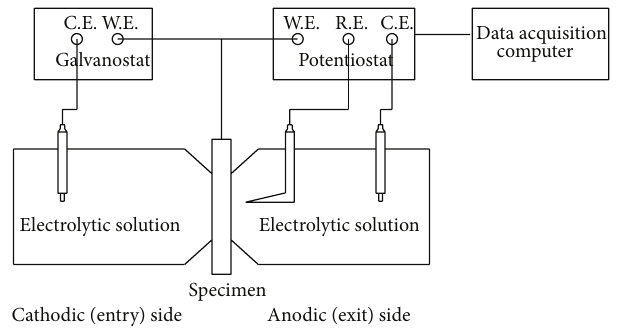
Figure 1: The schematic diagram of the experimental setup for hydrogen permeation